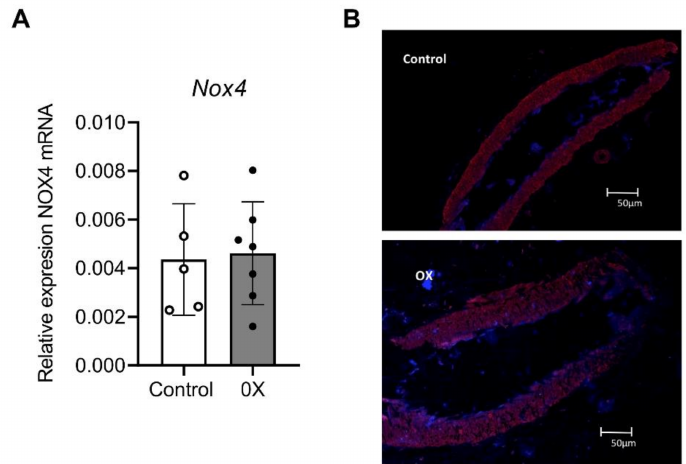
Figure 6. Unchanged Nox4 mRNA levels in preglomerular arteries from hyperoxaluric rats. ( A ) Com- parative Nox4 mRNA expression in samples of renal arteries from the control ( n = 5) and OX group ( n = 7), performed by RT-PCR. The delta CT method was used to determine the fold change for NOX4 gene relative expression in the arteries that were treated with water (control group) and with 0.75% EG (OX group). Values represent the mean ± SD. Statistical differences were calculated by a Student’s t -test for unpaired observations. No significant differences were found. ( B ) Immunofluorescence demonstration of NOX4 protein in a section of a renal interlobar artery from the Control and OX group. Immunofluorescence double labeling for TO-PRO marker (blue areas) demonstrates nuclear staining and for NOX4 protein (red areas).